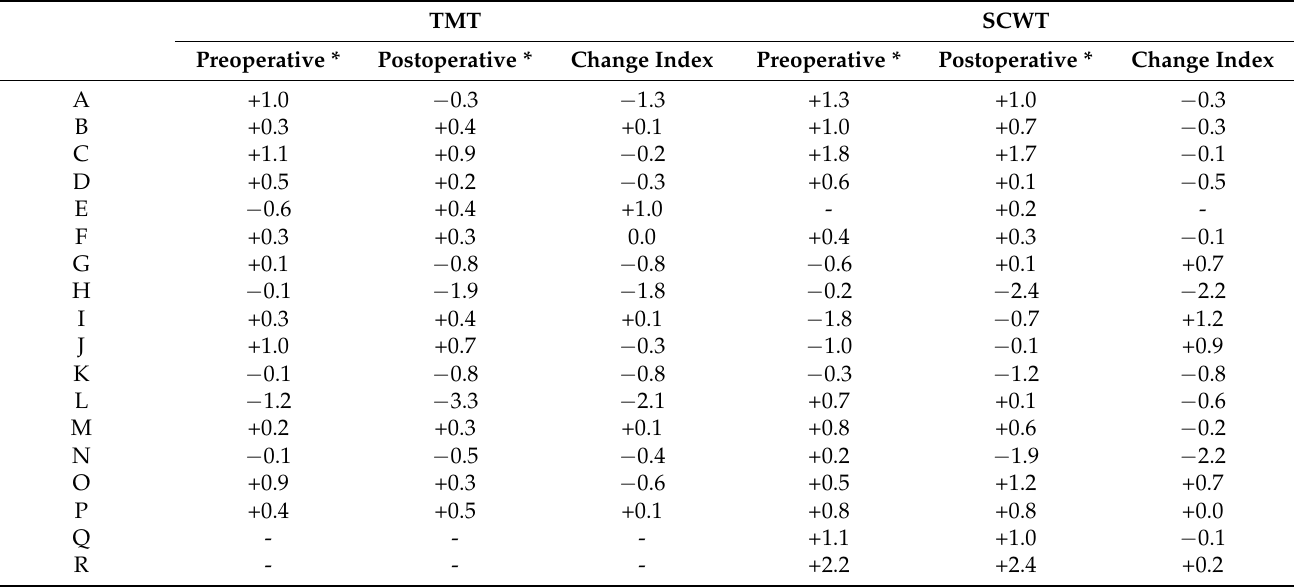
Table 2. Results from neuropsychological assessment. TMT